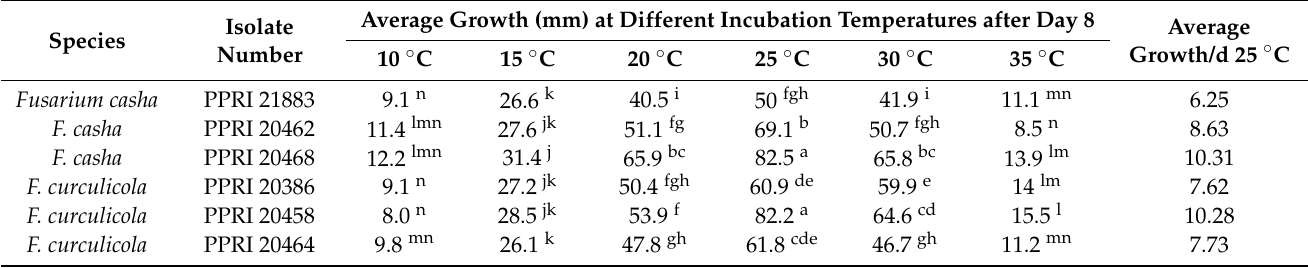
Table 3. Results of growth studies conducted on Fusarium casha and F. curculicola .